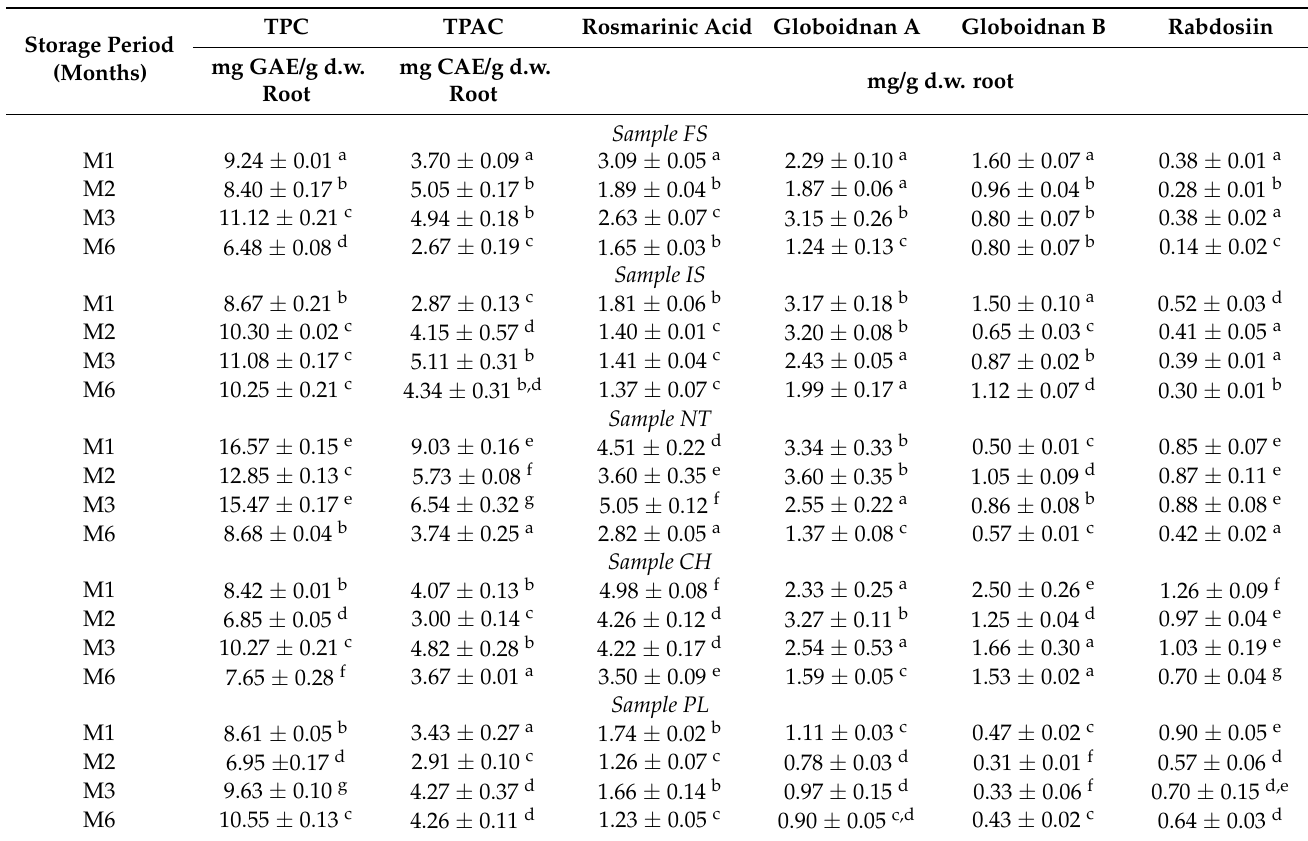
Data are presented as mean ± standard deviation (SD) of three determinations; values sharing different superscripts within columns are significantly different at p < 0.05 (Tukey’s test); CAE, caffeic acid equivalents; GAE, gallic acid equivalents; TPAC; total phenolic acid content; TPC, total phenolic